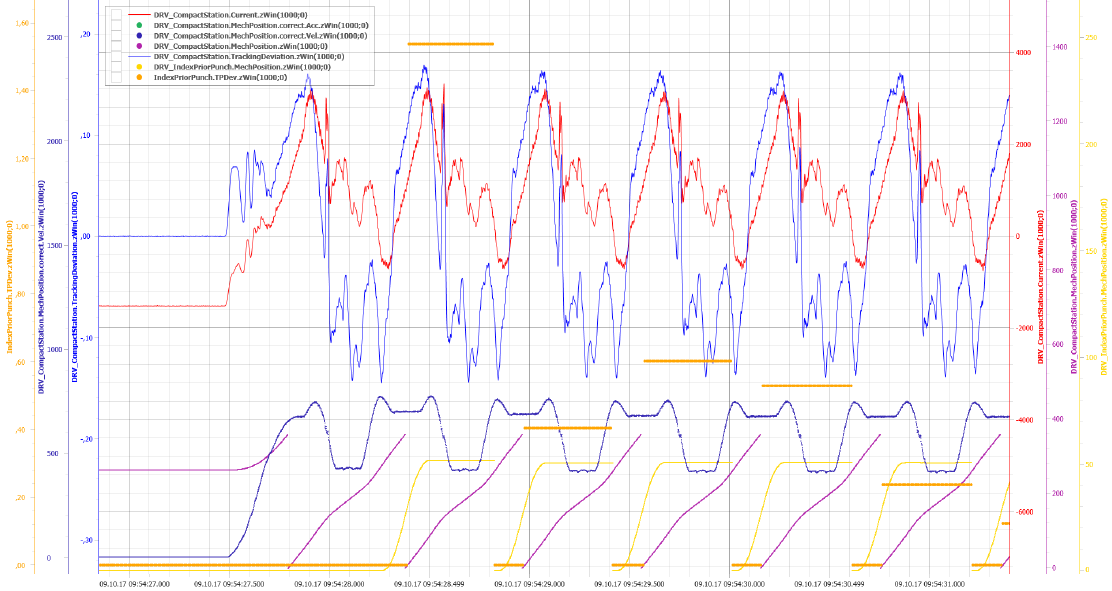
Figure 1. Signals of a compacting